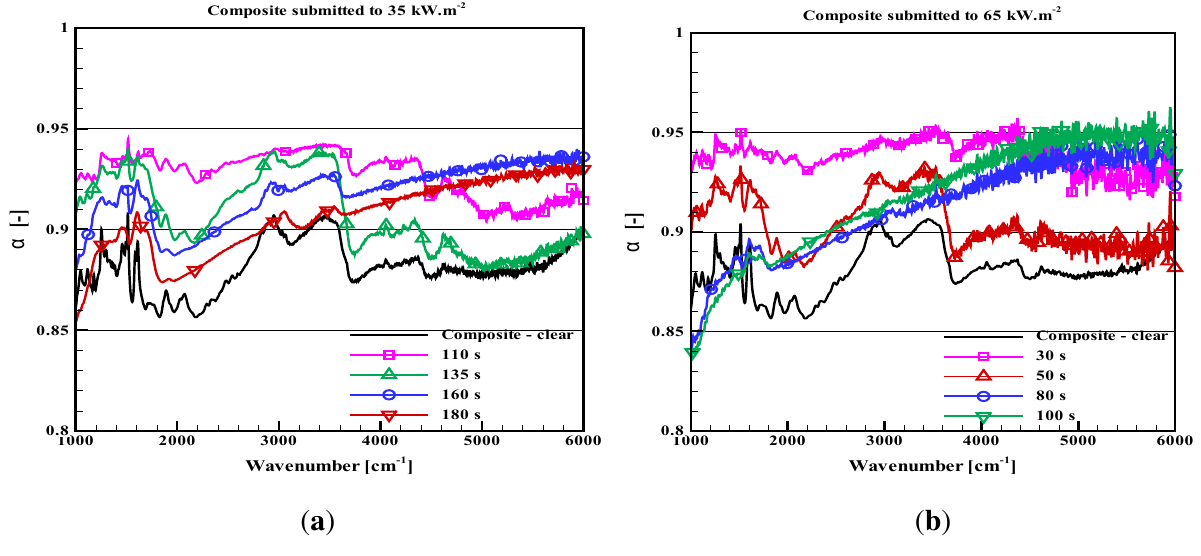
Figure 5. Absorptivity of a carbon composite submitted to thermal degradation during prescribed times. ( a ) Incident flux 35 kW/m 2 ; ( b ) incident flux 65 kW/m 2 . Of course, such averages are only fully representative of the material properties for samples with near grey behaviors, while hiding the problem of the spectral variations for non-grey materials. However, it will help to evaluate the requirement for an update of the radiative properties as the degradation occurs or conversely it will show if constant properties can be simply